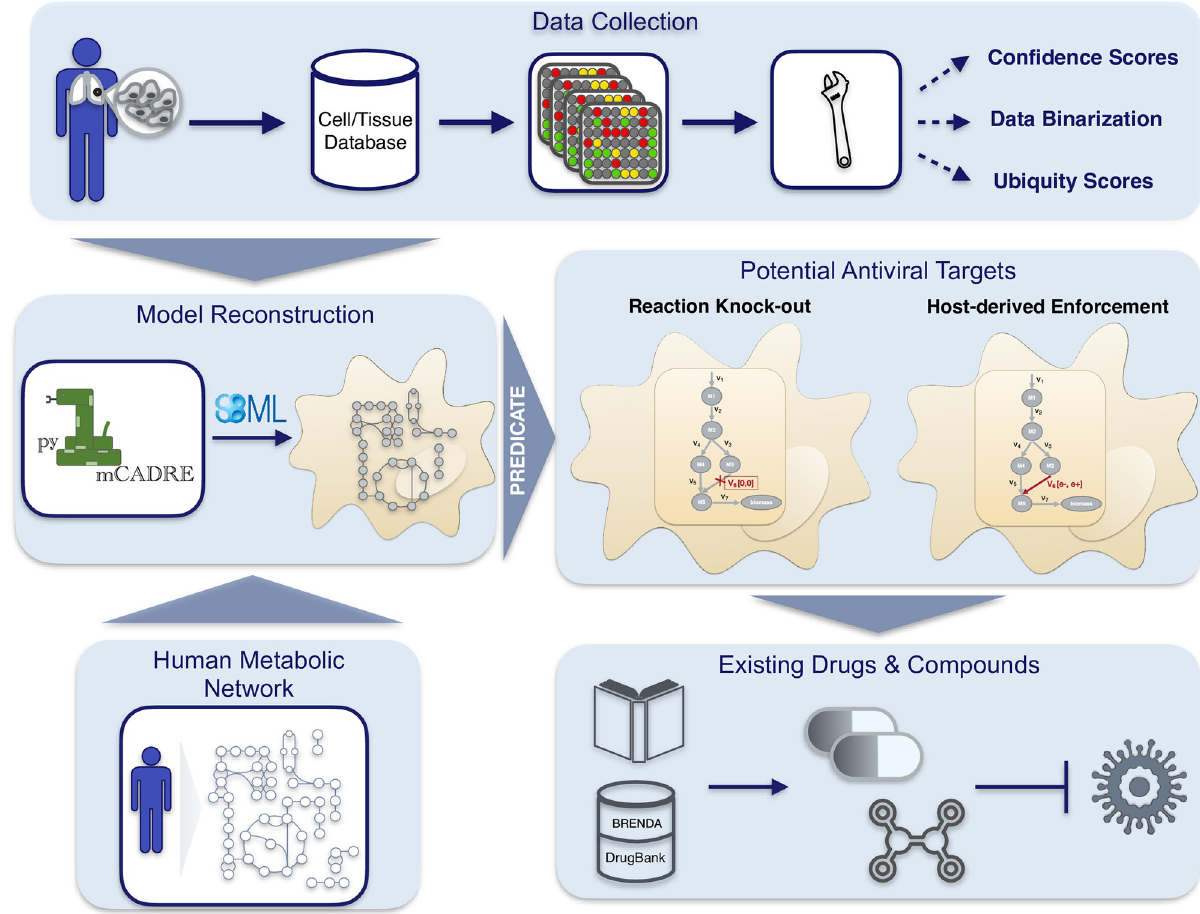
Fig 1. Workflow overview to reconstruct integrated host-virus genome-scale models and detect promising compounds with an antiviral activity. After collecting and curating the required data (the gene expression data and the human metabolic network), pymCADRE reconstructs a tissue-specific model using information from the network topology. The reconstructed metabolic network is then infected in silico with the virus of interest and is used to detect promising antiviral targets in an automated process. Detailed description of the process and the respective algorithm, called PREDICATE, is provided in Materials and Methods. Reaction knock-outs and the host-derived enforcement are used to detect exploitable enzymatic targets that keep the host maintenance at 100%, while suppressing the virus replication. The resulted top hits are further inspected manually in terms of already existing drugs and compounds in different databases, such as BRENDA and